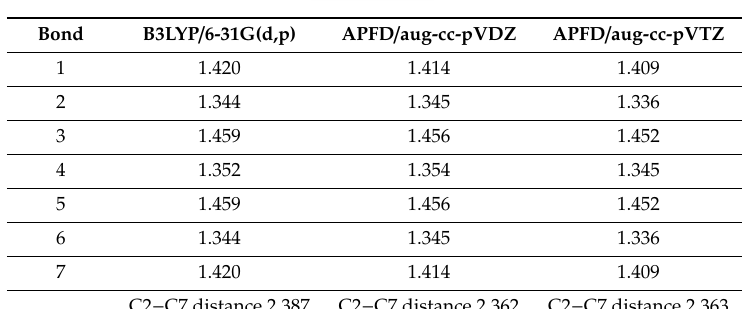
Table 13. Computational structures corresponding to the designated bonds in N -Methylazepine (lowest energy conformation). There are no corresponding experimental data. C − C Bond Lengths in Angstroms for N